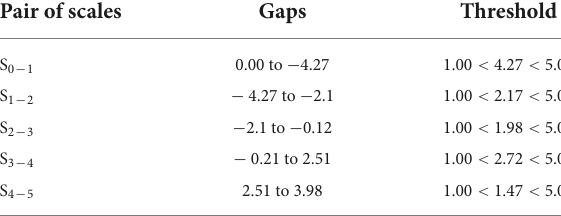
Most Rasch- Category probable Thurstone Peak for threshold probability